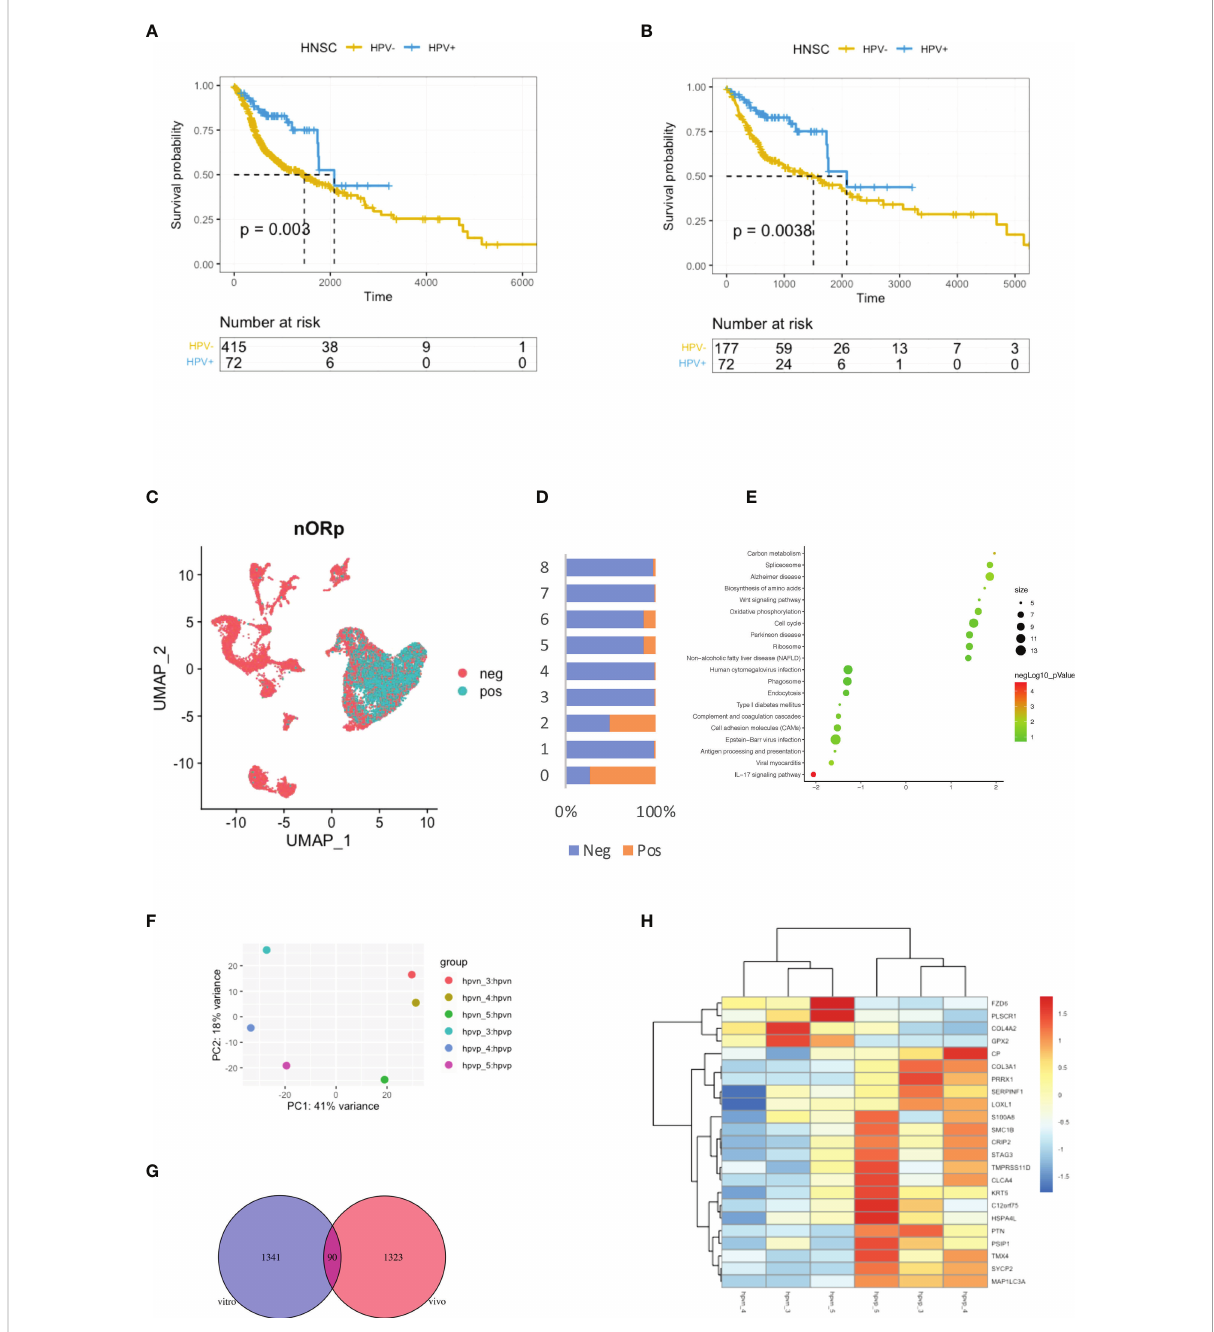
FIGURE 1 Virus analysis of the prognosis of high and low-risk groups of HNSCC patients. (A) Kaplan-Meier survival analysis of the HPV + group in HNSCC patients. (B) Kaplan-Meier survival analysis of the HPV + group in HNSCC patients who did not smoke. (C) UMAP diagrams showing HPV + and HPV - cells. (D) The bar graph quanti fi es and compares the proportion of HPV + and HPV - cells in the main cell types. (E) A bubble plot showing the enriched gene ontology of GSEA KEGG analysis of the DEGs in the HPV + cluster 0 cells. (F) A dot plot showing the PCA analysis of the 3 HPV + or HPV - cell lines. (G) A Venn diagram showing the overlapping number of DEGs from the HPV + tumour cells and HPV - cell lines. (H) A heatmap showing the expression of the overlapped DEGs in the HPV + and HPV - cell